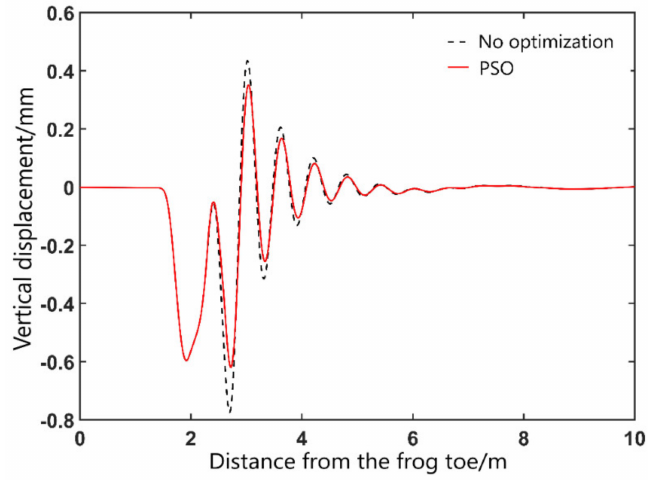
Figure 15. Wheelset vertical